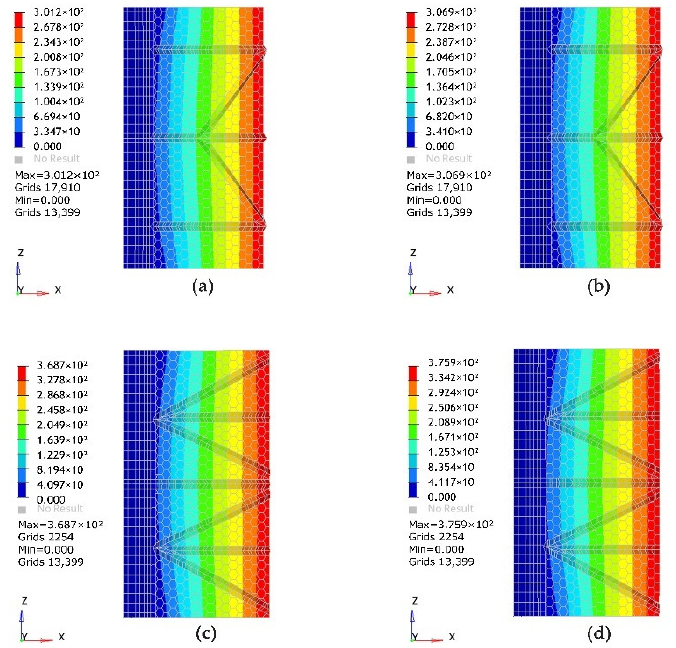
Figure 18. ( a ) Linear combined displacement analysis of carport I model under the load of 1.2 G k + 1.4 Q L + 1.4 × 0.85 Q W ; ( b ) Nonlinear combined displacement analysis of carport I model under the load of 1.2 G k + 1.4 Q L + 1.4 × 0.85 Q W ; ( c ) Linear combined displacement analysis of carport II model under the load of 1.2 G k + 1.4 Q L + 1.4 × 0.85 Q W ; ( d ) Nonlinear combined displacement analysis of carport II model under the load of 1.2 G k + 1.4 Q L + 1.4 × 0.85 Q W